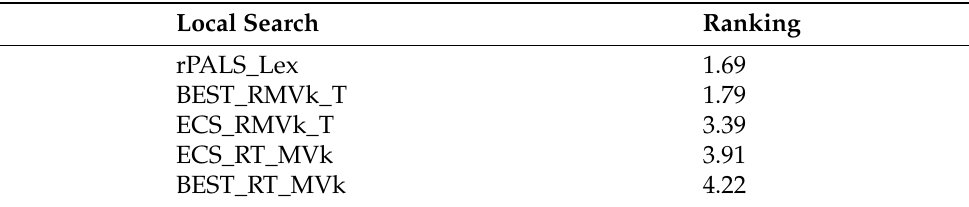
Table 12. Makespan Friedman ranking on the 400 scheduling problems (t-level).